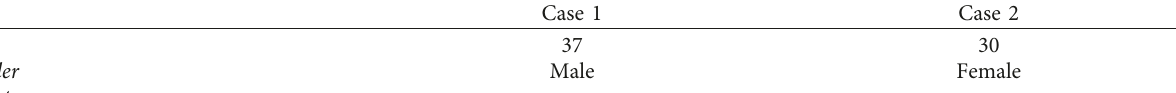
Table 1: Clinical features, initial test results, and imaging results of patients.